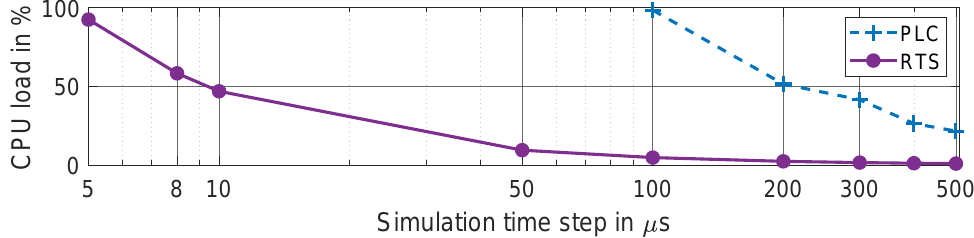
Figure 8. CPU load for the Bachmann MC210 and the OPAL OP5600 for different simulation time steps. A simulation time step of 200 µ s is given by Bachmann as the lowest possible time step. Nevertheless, the model runs at a time step of 100 µ s with a CPU load of 98.1%. Trying lower time steps leads to a software error at model